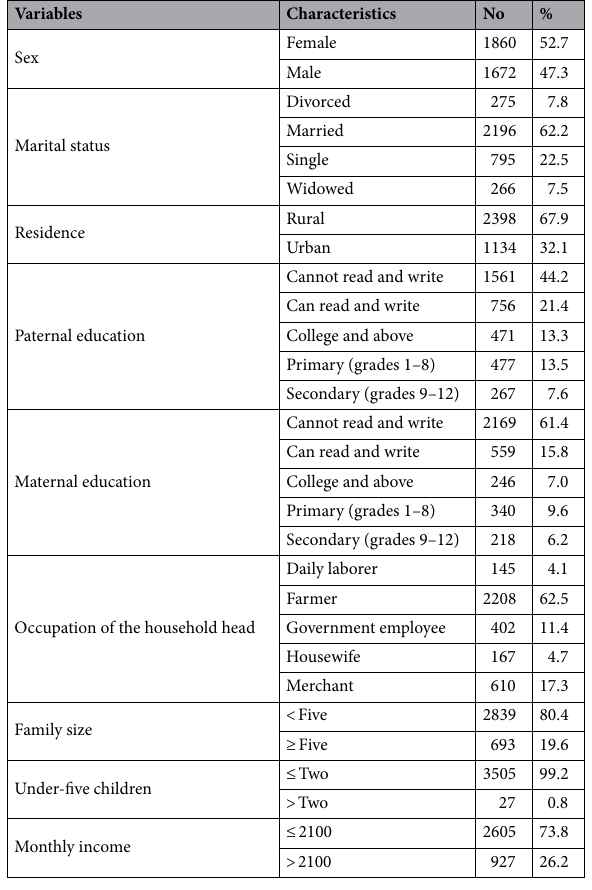
Table 1. Socio-demographic and economic characteristics of the study participants.